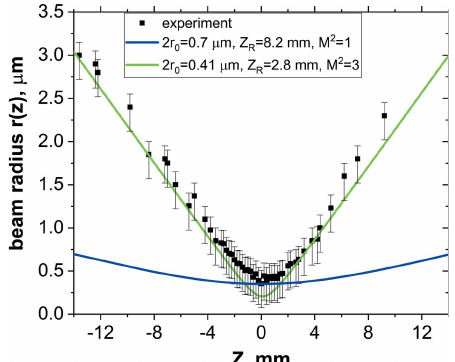
Figure 6 Comparison of the experimental radius r ( z ) for set CRL4 measured on the LiF images with the caustic calculated for different parameters r 0 and M 2